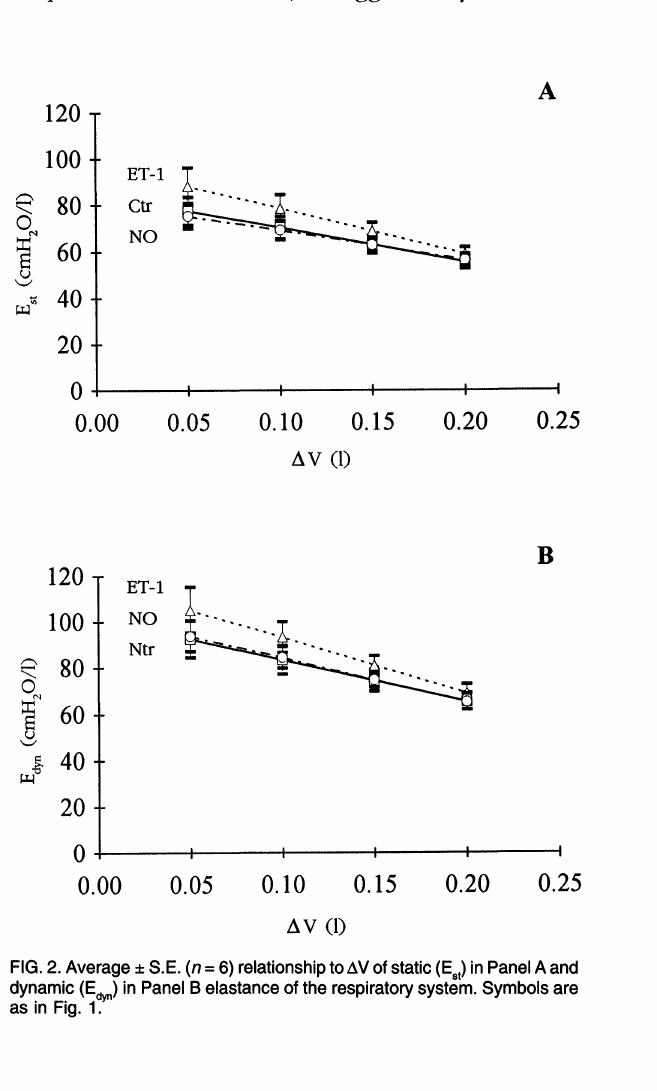
FIG. 2. Average S.E. (n 6) relationship to AV of static (Est) in Panel A and dynamic (E. ,) in Panel B elastance of the respiratory system. Symbols are as in Fig.